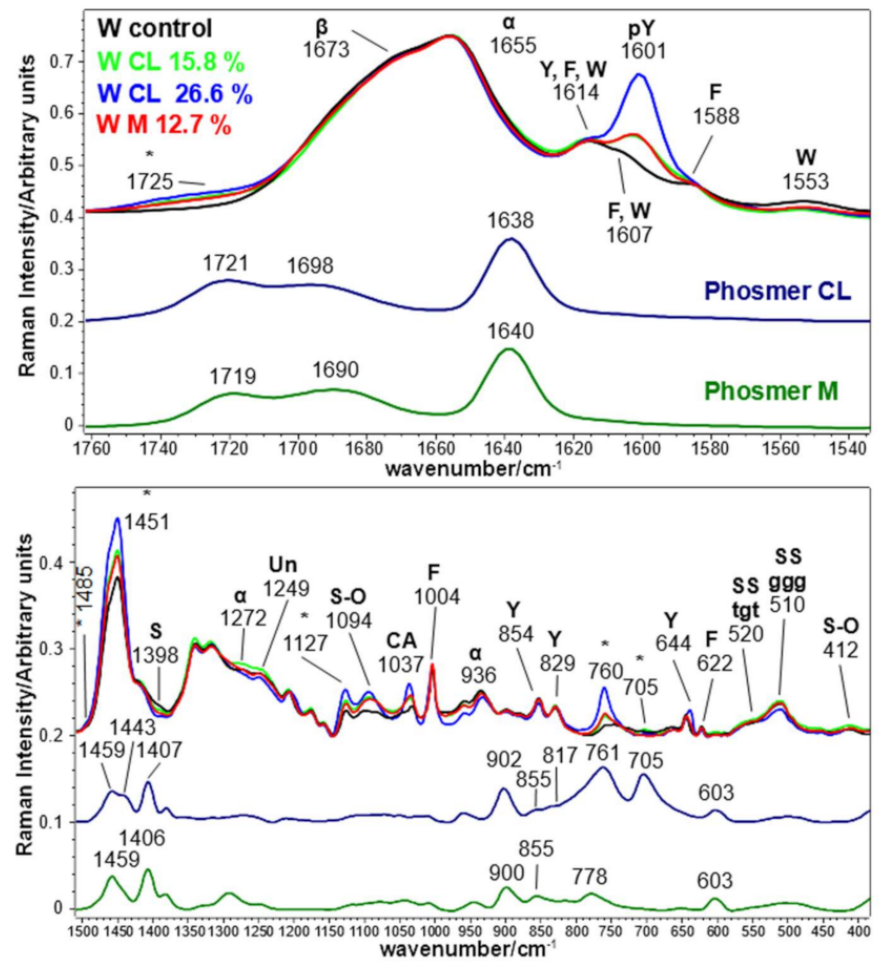
Figure 11. Raman spectra of wool keratin fabrics before (control) and after grafting with phosmer CL (weight gains 15.8% and 26.6%) and M (weight gain 12.7%). The spectra are normalized to the Amide I band. The spectra of phosmers CL and M are reported for comparison; the main bands that in the grafted samples strengthened due to their contribution are indicated with * (see Supplementary Material for assignments). The main bands assignable to β -sheet ( β ), α -helix ( α ) or unordered (Un) conformation as well as to tyrosine (Y), phenylalanine (F), phosphorylated tyrosine (pY), serine (S), tryptophan (W), cysteic acid (CA) and sulfated species (S-O) are indicated. The assignments to the main conformations adopted by disulfide bridges (SS), i.e., gauche-gauche-gauche (ggg) and trans-gauche-trans (tgt) are indicated,